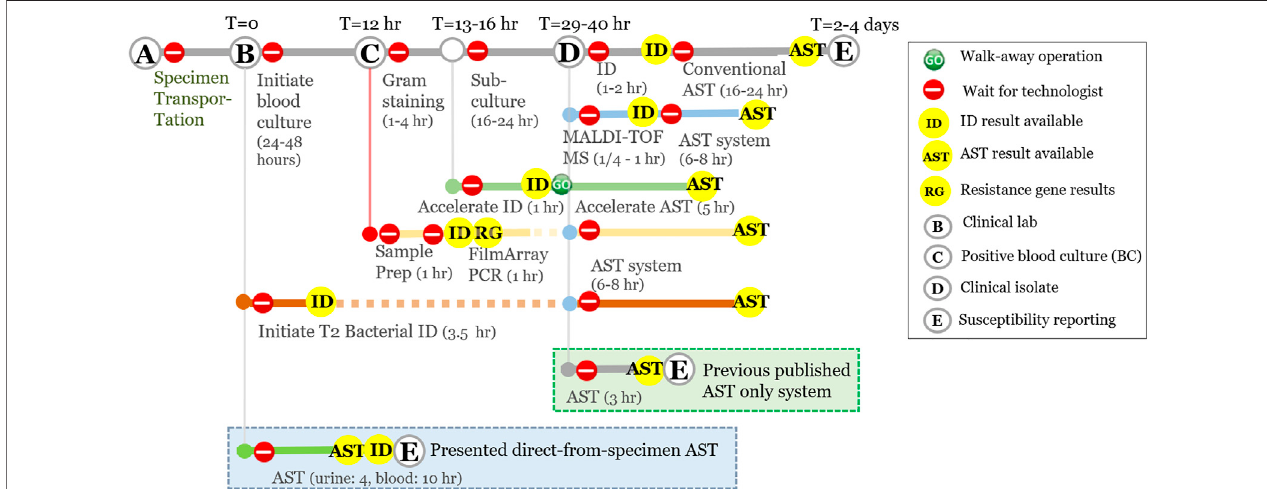
FIGURE 1 | Total turnaround time of proposed direct-from-specimen assays (blue box) compared to other methods used in the clinical microbiology laboratory.